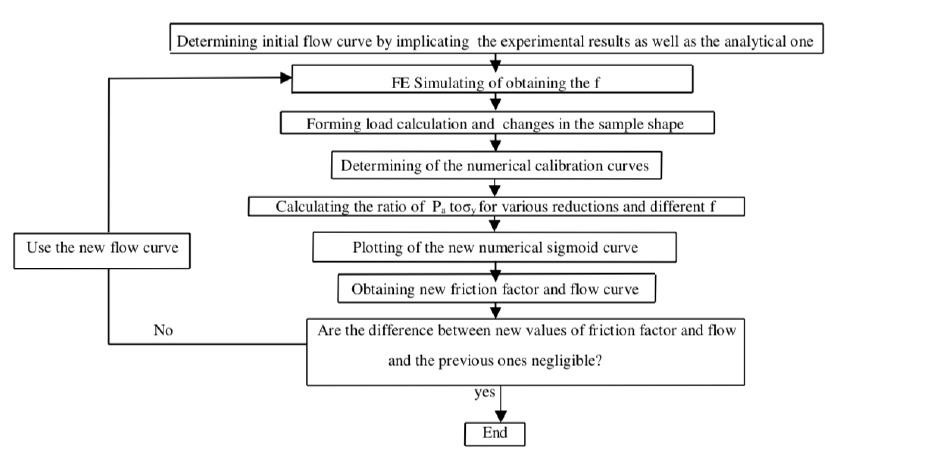
Figure 4: Determining the friction factor as well as the flow curve of the presented model.